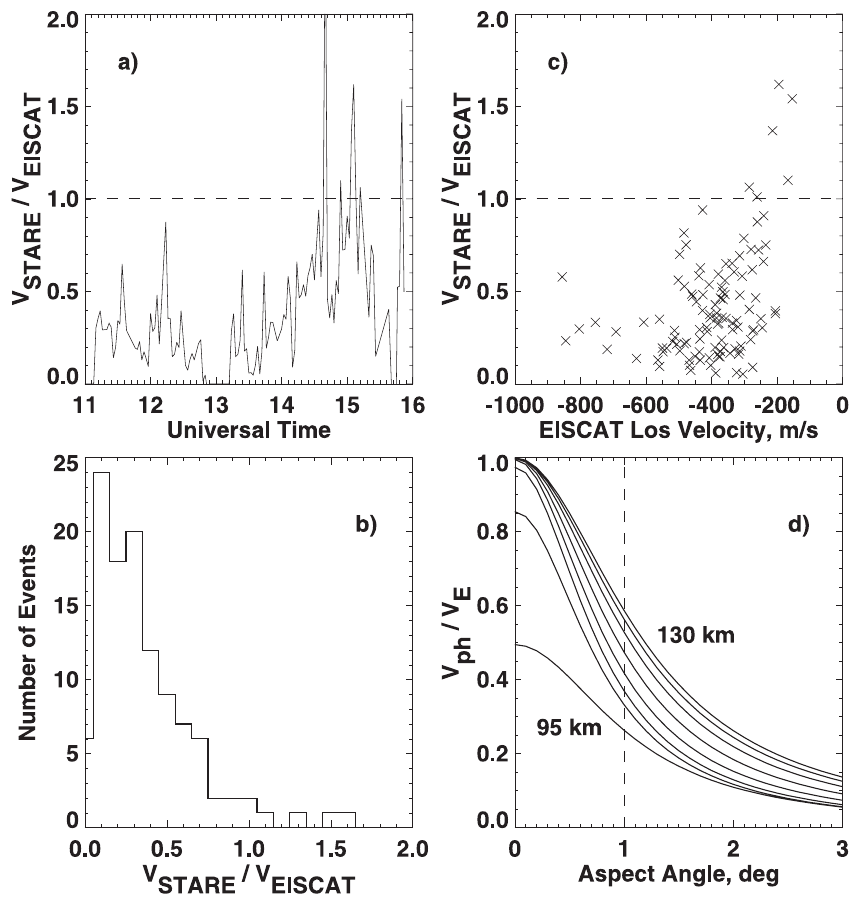
Fig. 10. Data on the observed STARE Finland velocities and lin- ear theory expectations. (a) Ra- tio of the Finland Doppler velocity to the EISCAT convection component R 1 = V STARE /V EISCAT for the whole period of observations at the EISCAT spot. (b) Statistics of R 1 values. (c) Ratio R 1 as a function of the convec- tion component magnitude. (d) Ratio of the irregularity phase velocity (accord- ing to the linear fluid theory of electro- jet irregularities) to the convection com- ponent as a function of the aspect angle. Curves are given for heights 95–130km with 5-km